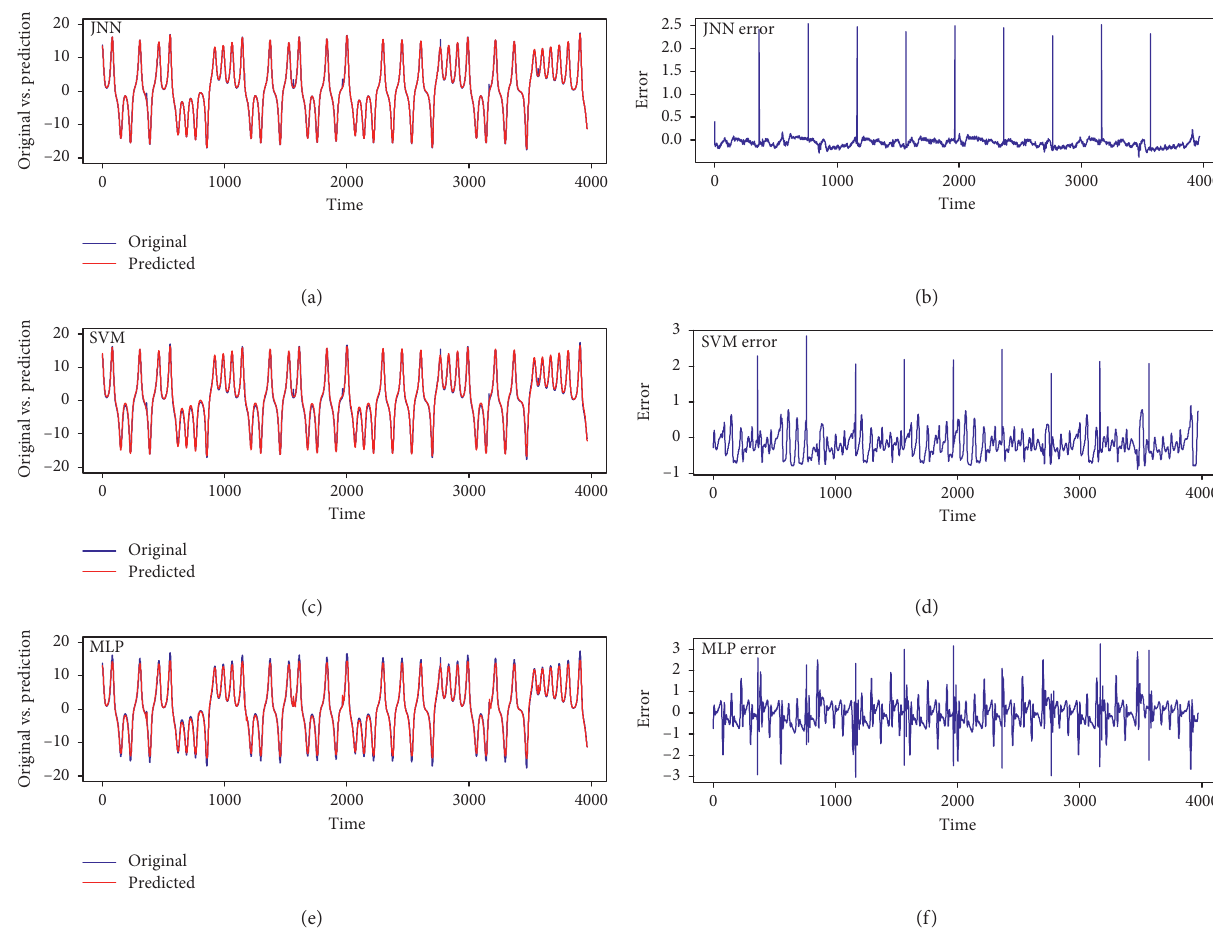
Figure 6: Comparison diagram of original signal and predicted signal and the predicted error diagram: (a) original signal vs. the result of Jordan neural network; (b) Jordan neural network prediction error; (c) original signal vs. the result of support vector machine; (d) support vector machine prediction error; (e) original signal vs. the result of multilayer perceptron; (f) multilayer perceptron prediction